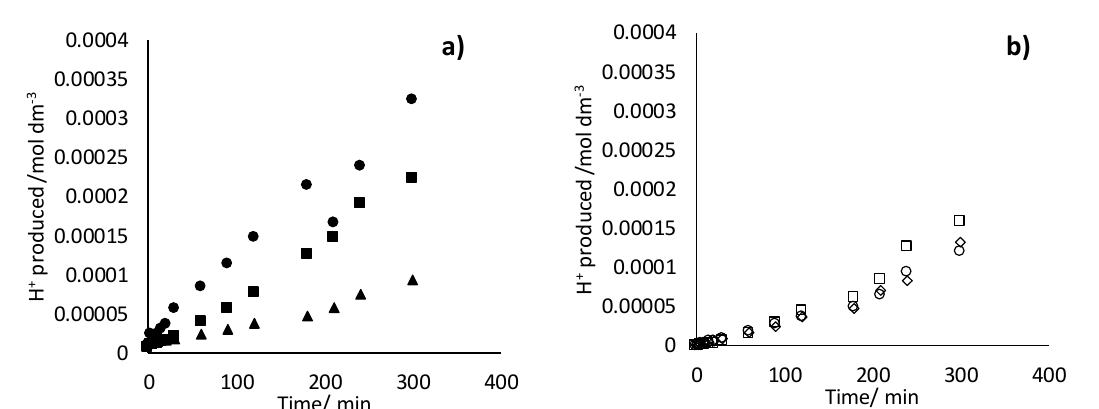
Figure 7. ( a ) Concentration of protons produced during the electrolytic tests at 6.77 mL·s − 1 of flowrate. Current density: ( ▲ ) 20 mA·cm − 2 ; ( ■ ) 50 mA·cm − 2 ; ( ● ) 100 mA·cm − 2 . ( b ) Concentration of protons produced during the electrolytic tests at 50 mA·cm − 2 of current density. Flowrate: ( □ ) 10.166 mL·s − 1 ; ( ○ ) 11.66 mL·s − 1 ; ( ◊ ) 12.833 mL·s − 1 .